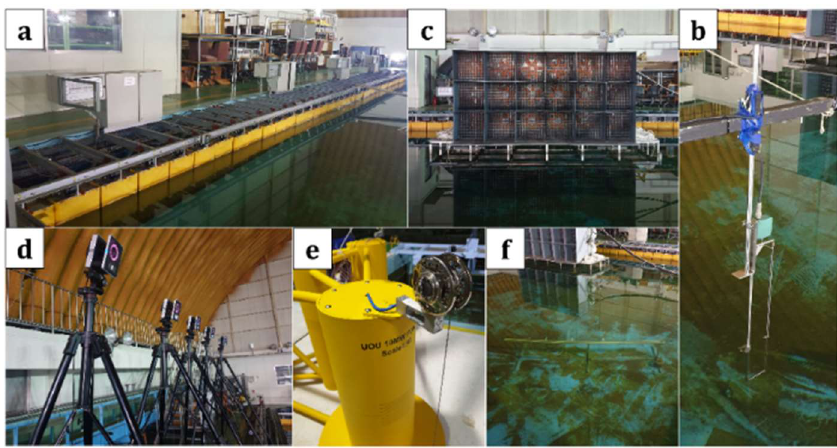
Figure 7. Experimental equipment – (a) Wave maker, (b) Wave probe, (c) Wind generator, (d) Motion-capture cameras, (e) Load cell through a roller, (f) Mooring table.